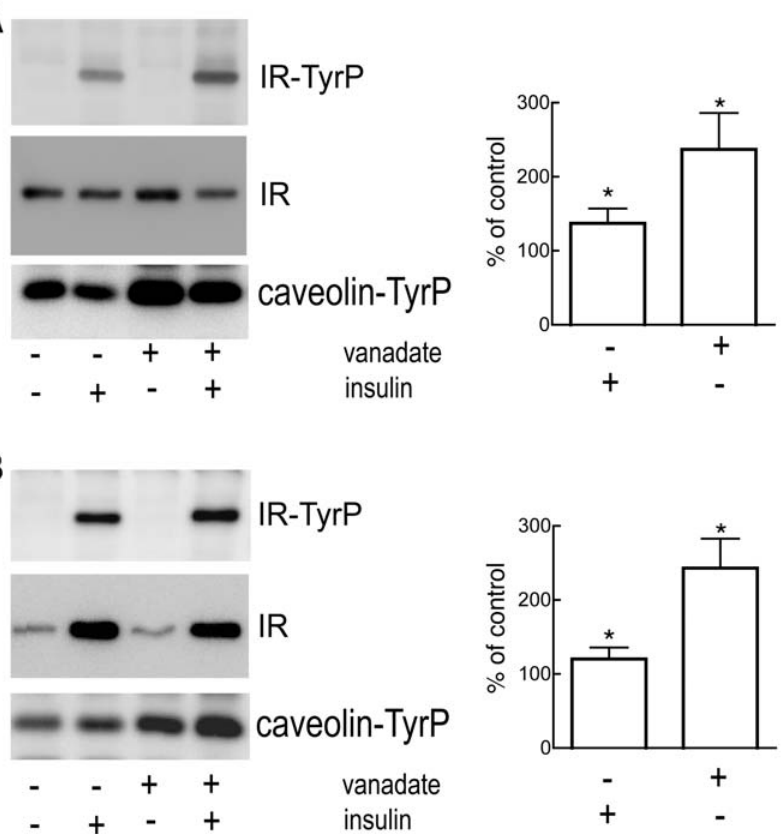
Figure 2. Effects of vanadate on endocytosis of the insulin receptor. Isolated adipocytes were incubated with or without 2 mM Na-ortho- vanadate for 20 min, when insulin at 100 nM was added for another 10 min, as indicated. Cells were then homogenized and plasma membrane ( A ) and endosomal ( B ) fractions isolated. Equal amounts of protein were subjected to SDS-PAGE and immunoblotting with (from the top) antibodies against phosphotyrosine (indicated is the insulin receptor, IR-TyrP), insulin receptor b -subunit (IR), and tyrosine(14)-phosphorylated caveolin-1 (caveolin-TyrP). Bar graphs show the quantitation of tyrosine(14)-phosphorylated caveolin-1 as percent of controls without additions, in 7 separate experiments, mean 6 SE. *, p , 0.05 by Student’s t-test.